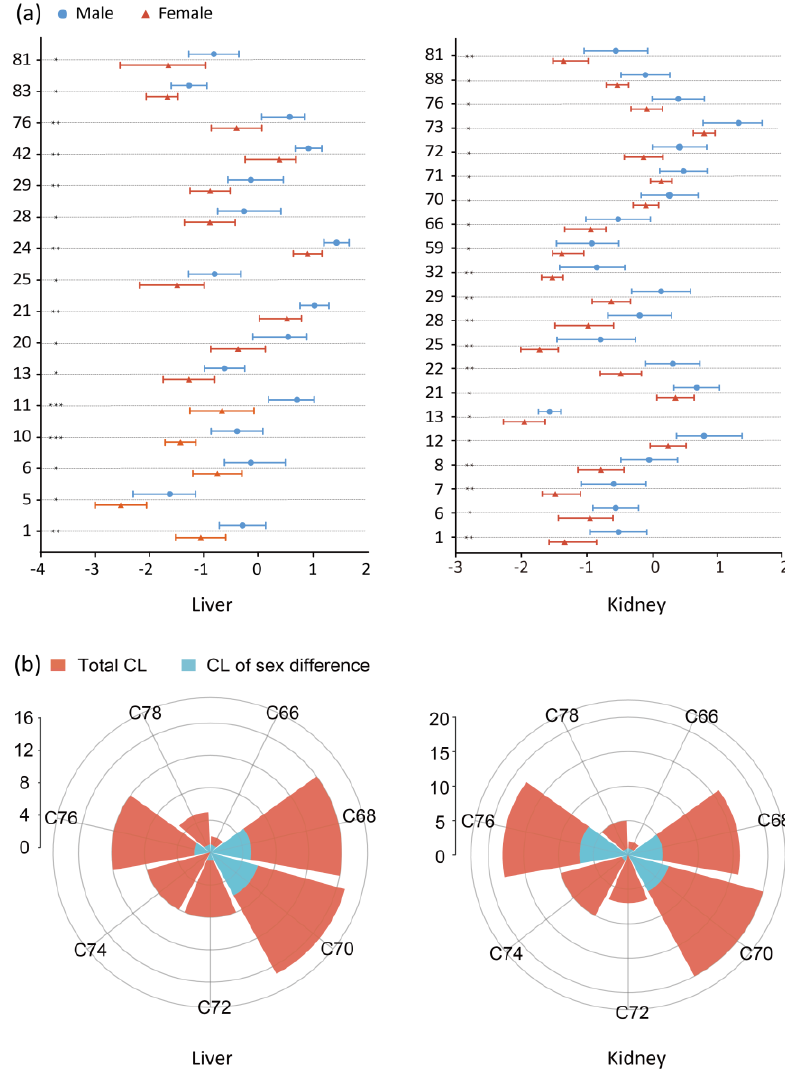
Figure 5. ( a ) Relative contents of CLs detected in different sex of liver and kidney tissues. The results were presented as the mean ± SD (n = 7). * p < 0.05, ** p < 0.01, *** p < 0.001 for male vs. female. The values of each CL were the log 10 logarithm transformation of their relative peak area. The numbers of compounds are consistent with those in Table 1. ( b ) The distributions of significant differential CLs and total CLs in tissues, stratified by the C number in liver and kidney tissues. The CLs based on the number of C atoms were divided into seven groups. The diameter is equal to the number of CLs. Table 3. Relative contents of CLs in different sex of liver and kidney.